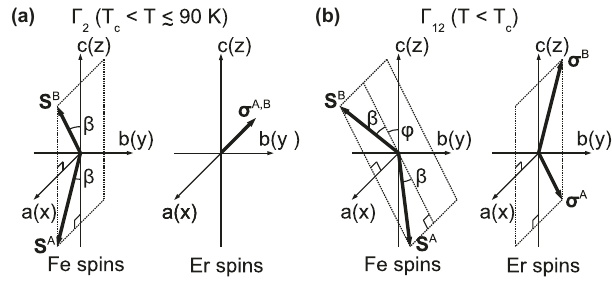
Fig. 1 Spin con fi gurations in ErFeO 3 below and above T c ~ 4 K. In this study, we considered two-sublattice models both for Er 3 þ and Fe 3 þ spins. a In the high-temperature ( T c < T ≲ 90K, Γ 2 ) phase, the Fe 3 þ spins are ordered antiferromagnetically along the c axis with a slight canting toward the a axis. The Er 3 þ spins are paramagnetic and directed toward the a axis by the weak Fe 3 þ magnetization. b In the low-temperature ( T < T c , Γ 12 ) phase, the Er 3 þ spins are ordered antiferromagnetically along the c axis, and the antiferromagnetic (AFM) vector S A (cid:3) S B of the Fe 3 þ spins rotates in the bc